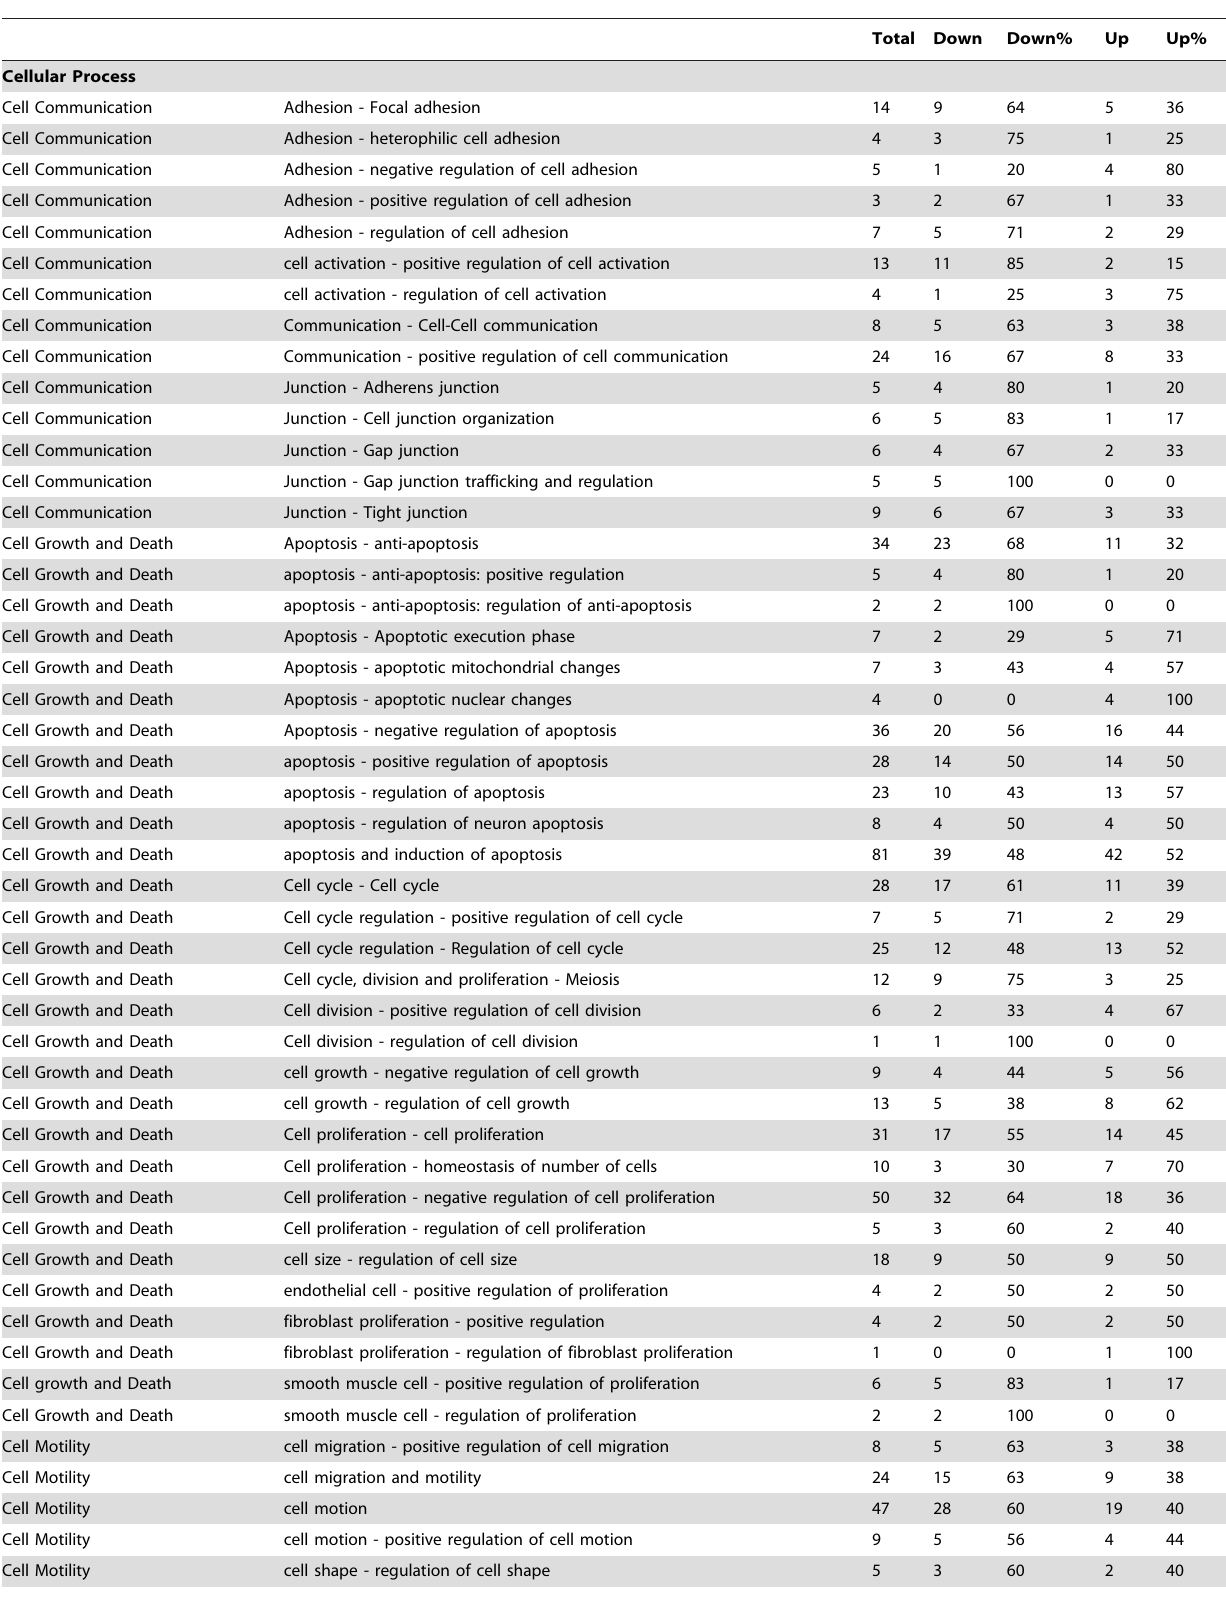
Table 1. Pathway summary of DE genes that are related to six biological systems of PAMs infected with PRRSV.